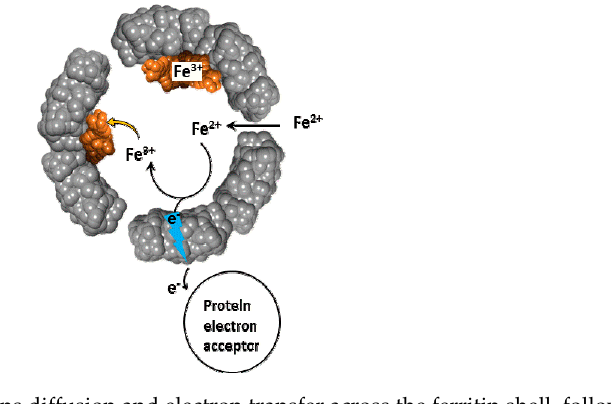
Figure 5. Schematic of Fe 2+ cations diffusion and electron transfer across the ferritin shell, followed by Fe 2+ oxidation and deposition.